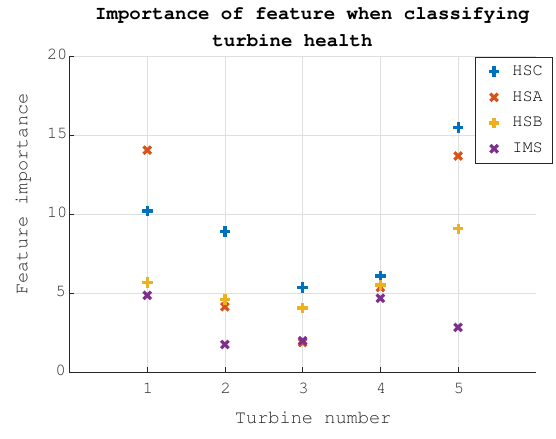
Figure 7. Dataset 1